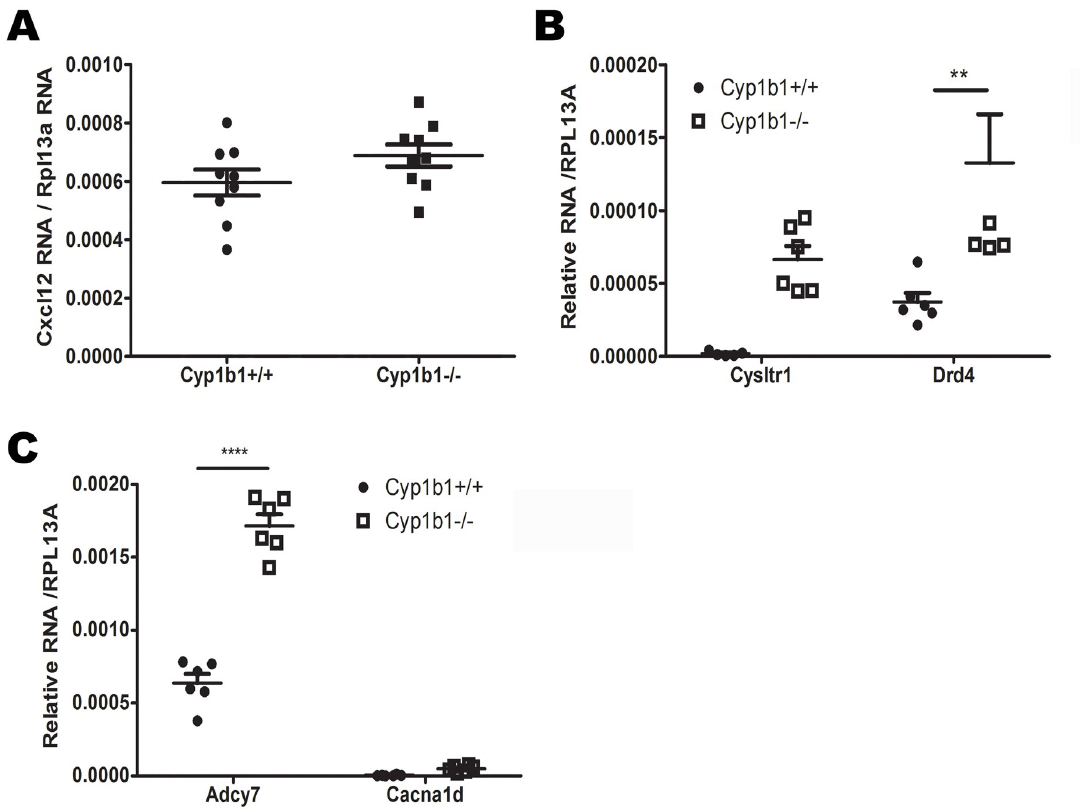
Fig 3. RT-qPCR validation of DEG from different pathways. (A) Genes related to the axon guidance pathway. (B) Genes related to the Neuroactive ligand-receptor interaction pathway. (C) Genes related to the Calcium signaling pathway. ( �� P < 0.01, ���� P < 0.0001, n � 6).